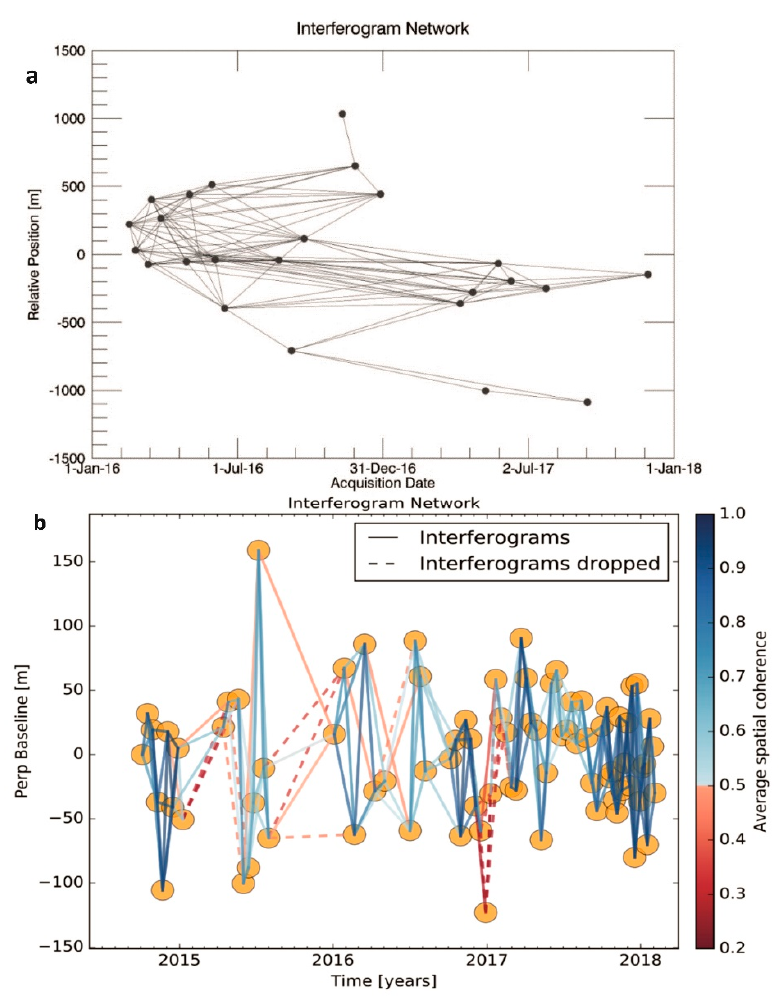
Figure 3. ( a ): Interferogram network configuration of COSMO SkyMED images processed by Small BAseline Subset (SBAS). ( b ): Interferogram network configuration of the Sentinel-1 images processed by SBAS.